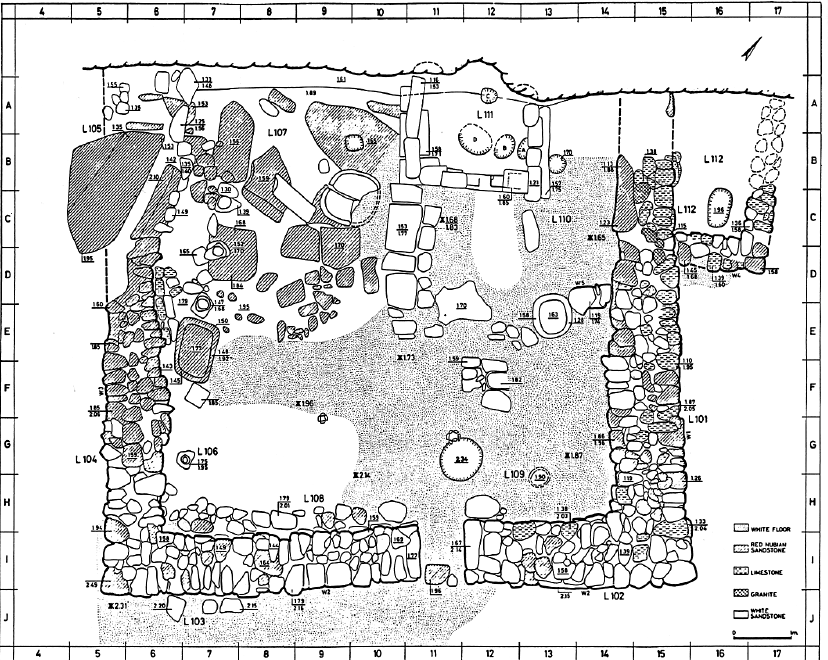
Figure 5 Temple of Hathor at Timna Site 200. Plan of excavation. After Rothenberg 1988, Ill. 6. With kind permission from the Institute for Archaeo-Metallurgical Studies, University College